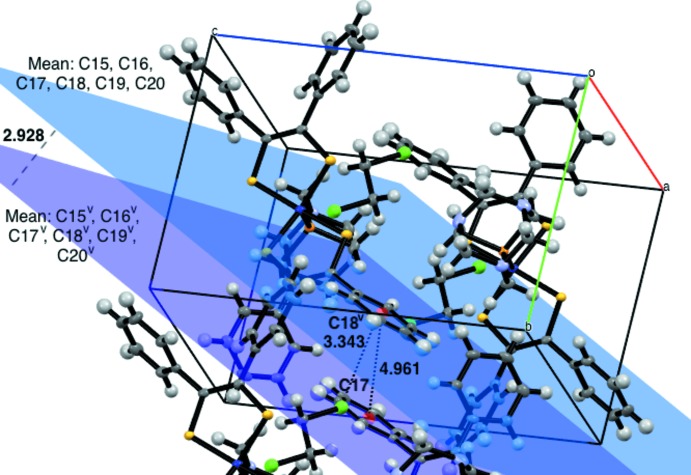
View of two mol­ecules of [Co(C14H10S2)2(C6H12N3P)]·0.5C2H4Cl2 within the unit cell and one additional translation of the unit cell along b, at 50% probability ellipsoids. Planes defined by aryl rings containing C15–C20 along with the corresponding centroids are depicted to highlight parallel displaced π-stacking of aryl rings.